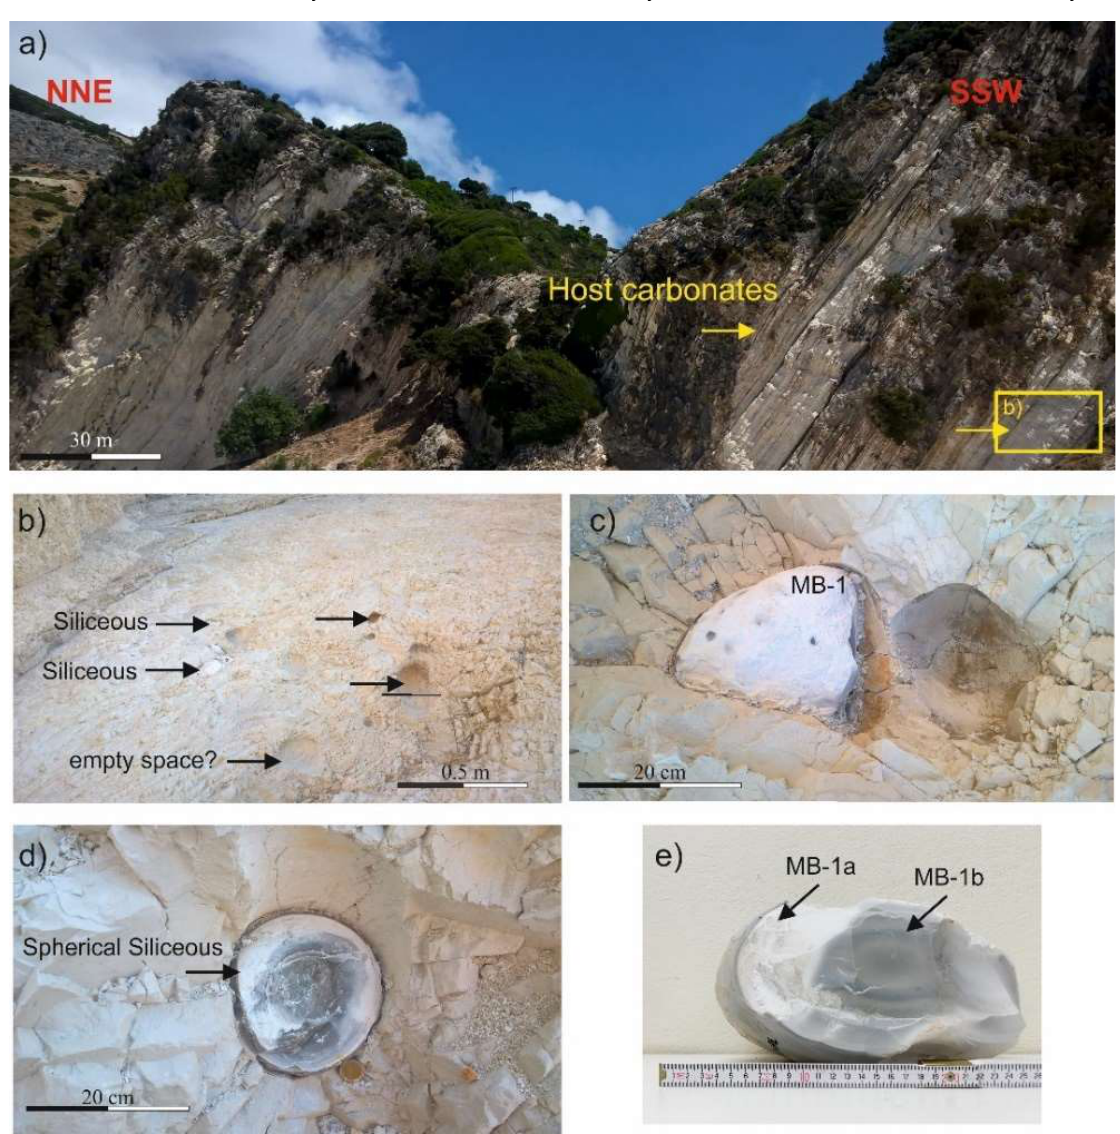
Figure 2. ( a ) Field view of the Myrtos Beach section; ( b ) MB sampling point with widespread siliceous subspherical nodules in carbonate strata; ( c , d ) detail view of in situ siliceous nodules; ( e ) macroscopic view of sample MB1.